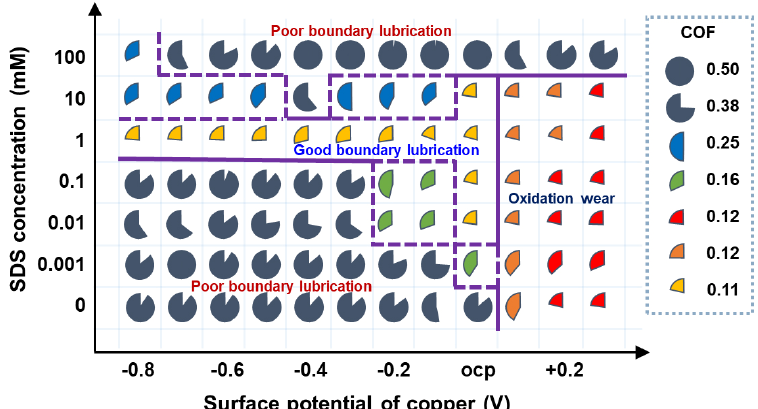
Fig. 4 Friction map of Cu/ZrO 2 tribo-pairs lubricated with different concentrations of SDS aqueous solutions under different surface potentials.